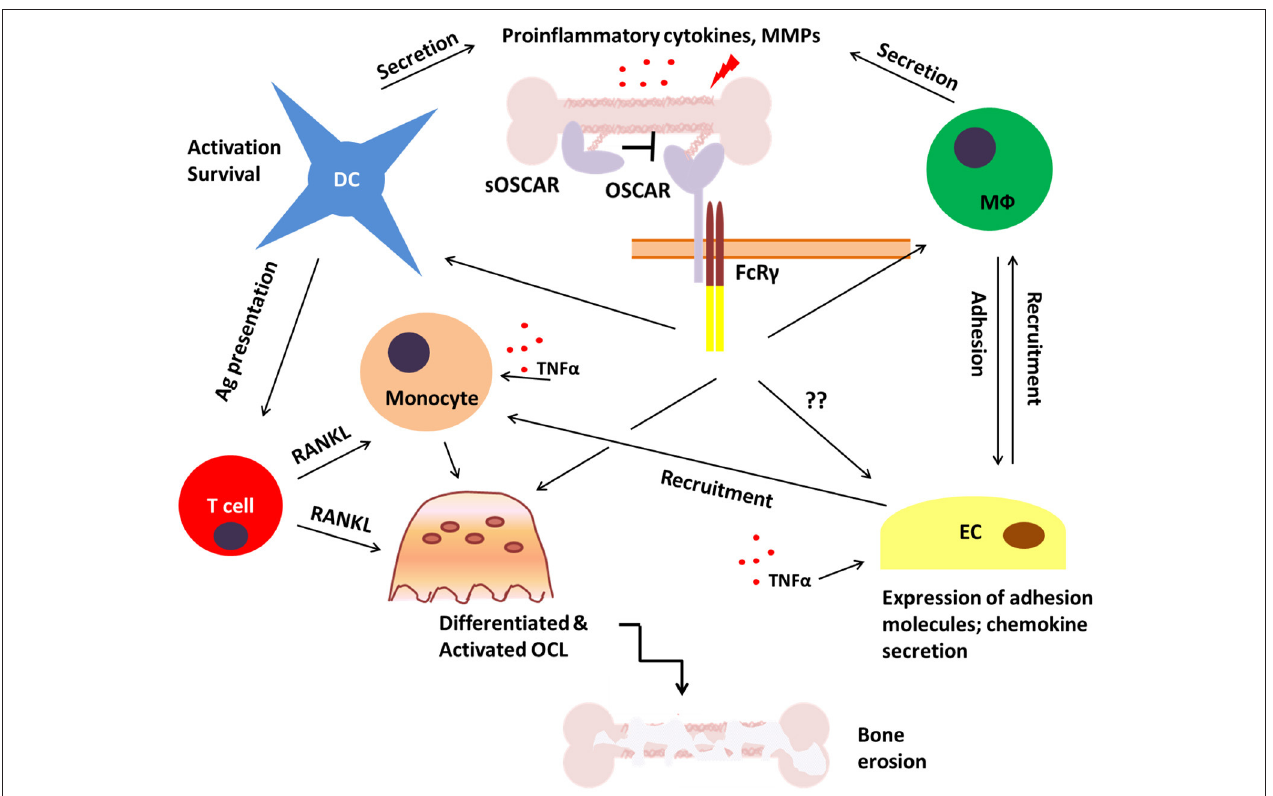
FIGURE 5 | Potential role of OSCAR in bone disease. During inflammatory bone disease inappropriate and prolonged activation of immune cells may lead to enhanced release of pro-inflammatory mediators such as cytokines, chemokines and matrix metalloproteinases (MMPs). This would stimulate the expression of adhesion molecules on endothelial cells (EC) and facilitate the recruitment of OSCAR-expressing immune cells including monocytes, dendritic cells (DC), and macrophages (M φ ). This may lead to both amplification of the inflammatory process and enhanced osteoclastogenesis which would eventually result in bone erosion and fragility. A soluble form of OSCAR (sOSCAR) may prevent excessive signaling via OSCAR-FcR γ through competition for OSCAR ligands, although the current evidence for this is conflicting. OSCAR-FcR γ complex is also expressed on ECs, but little is known about its role in these cells in relation to bone